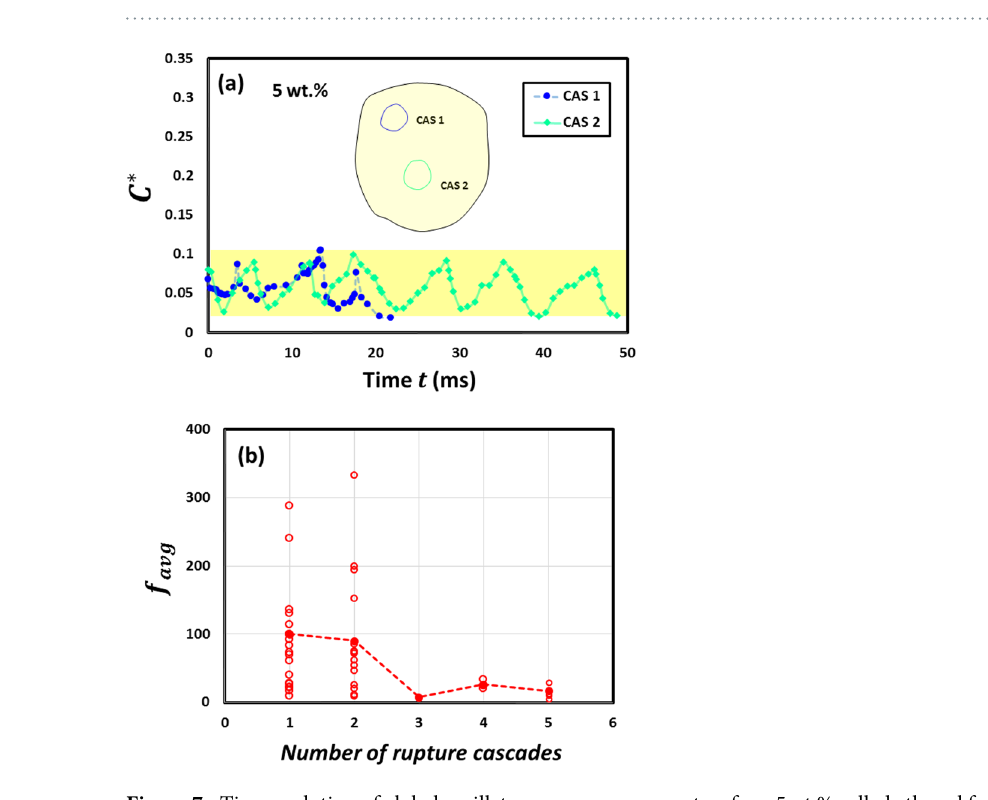
1 of the droplet as a avg ∑ + t t N (